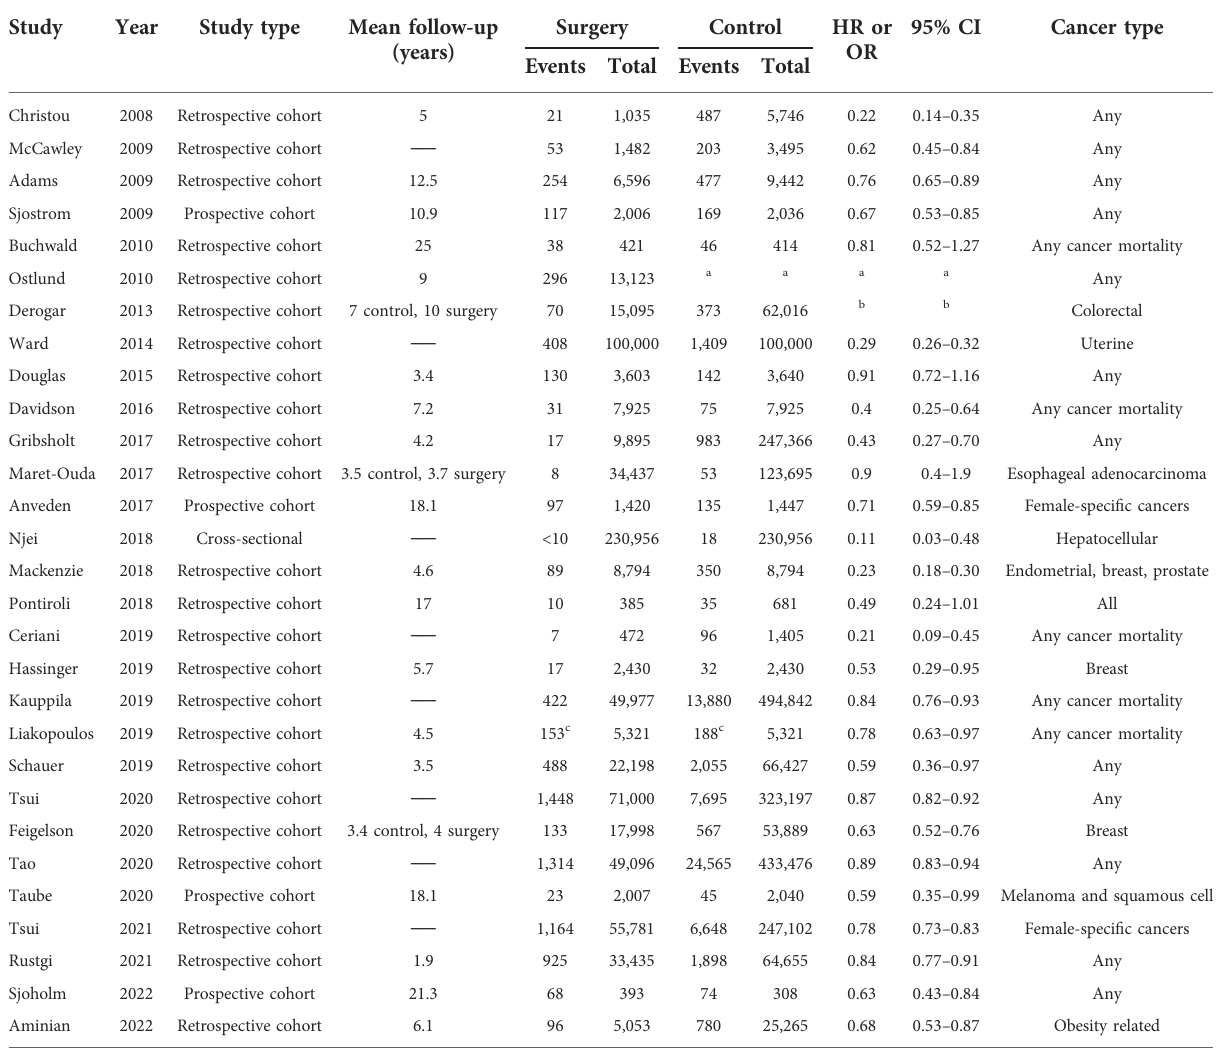
TABLE 1 Selected studies examining metabolic/bariatric surgery and cancer